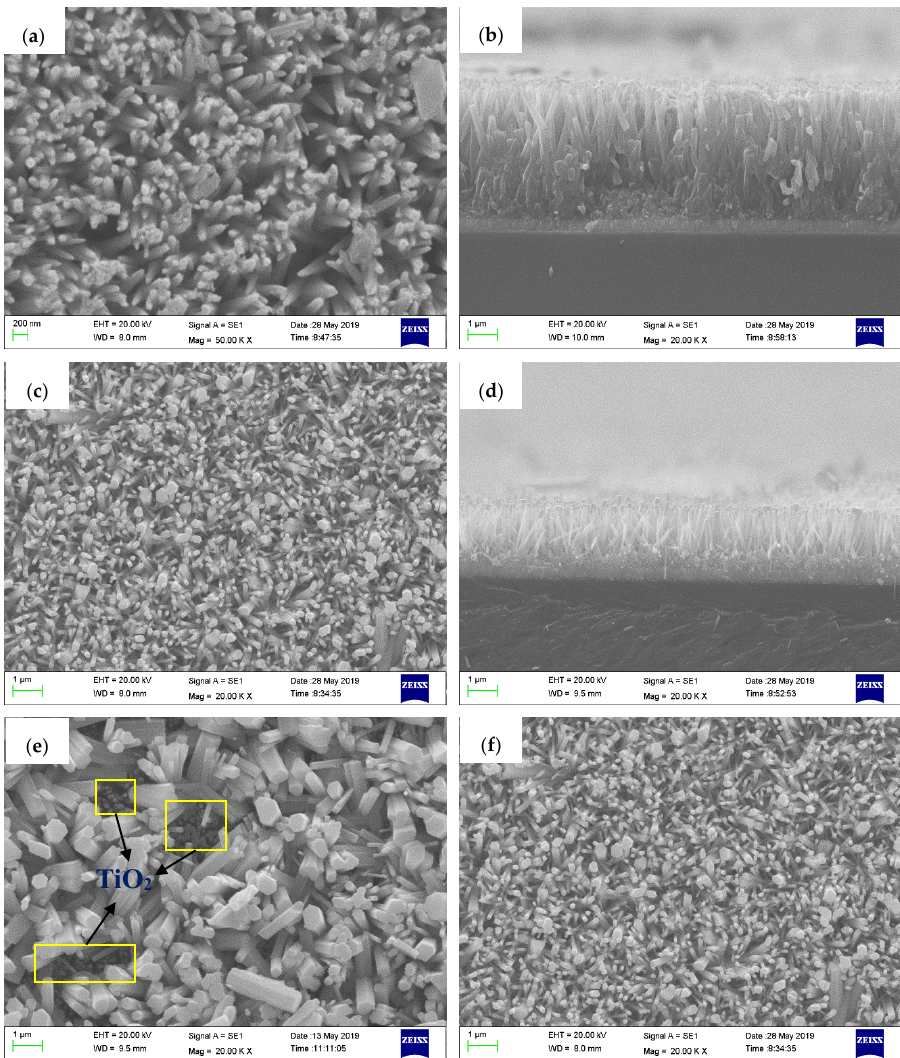
Figure 2. SEM images of ( a ) TiO 2 nanorod arrays. ( b ) Sectional view of TiO 2 nanorod arrays. ( c ) ZnO nanorod arrays. ( d ) Sectional view of ZnO nanorod arrays. ( e ) ZT1 film. ( f ) ZT2 film grown on FTO substrate.